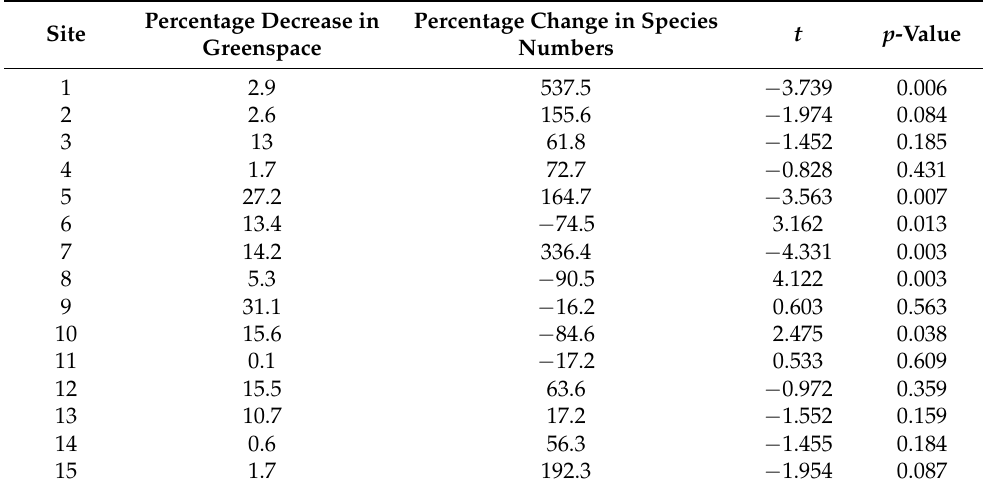
Table 2. Results of paired t -test for difference in the overall number of bird species per site between 1998 and 2018 in areas where greenspace has decreased (df =